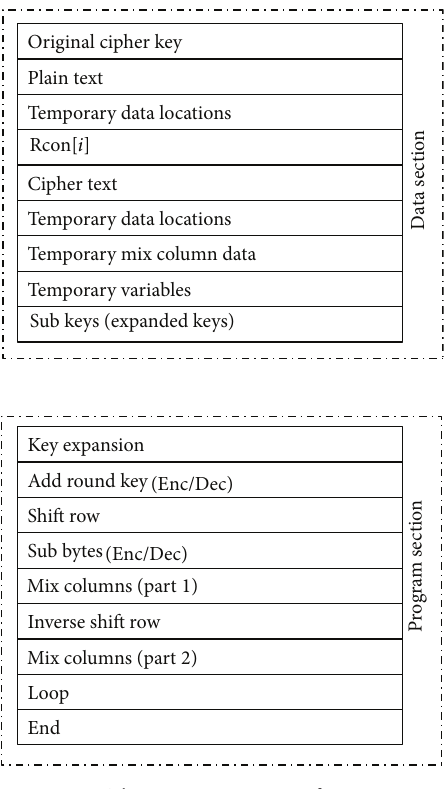
Figure 20: The memory mapping for CISA